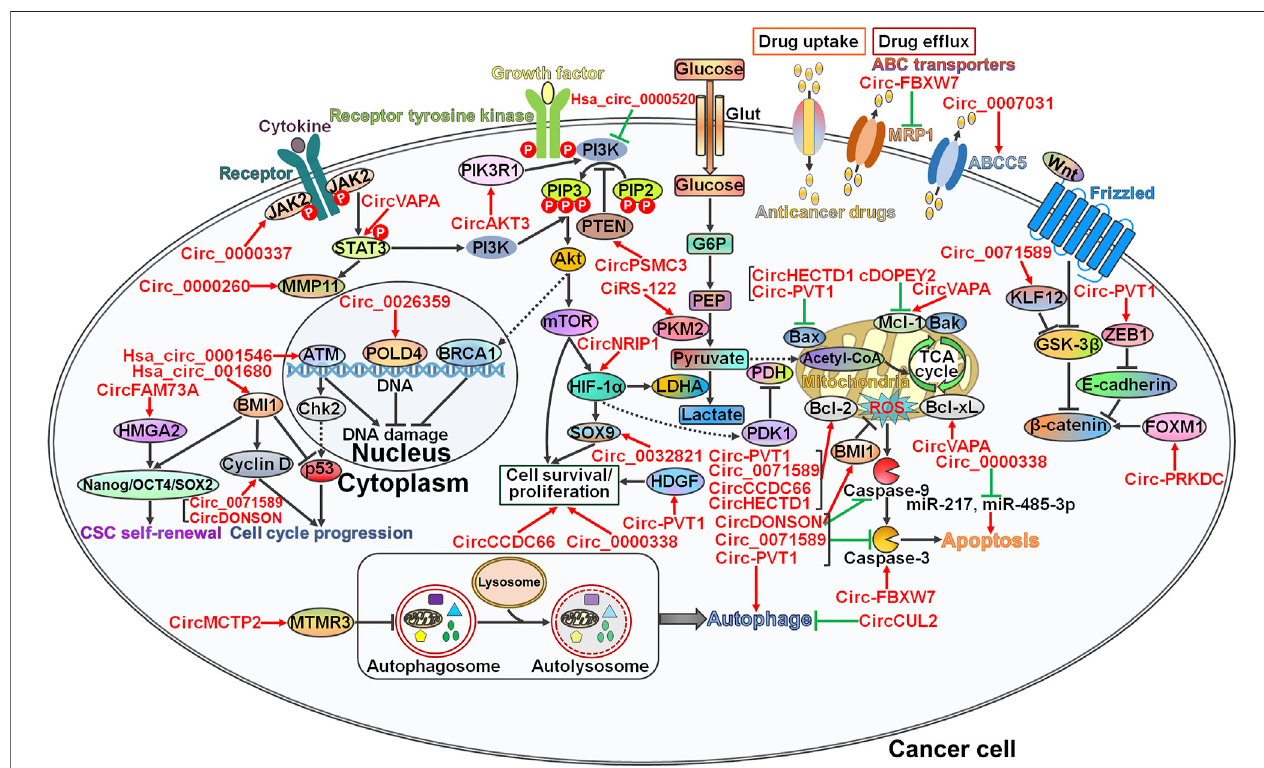
FIGURE2| TheunderlyingmechanismsinvolvedincircRNA-mediatedchemoresistanceingastrointestinalcancer.CircRNAsfunctionasmasterregulatorsofdrug resistanceingastrointestinal(GI)cancerviadiversepathways.Circ_0000337andcircVAPAstrengthenchemotherapy-resistantcharacteristicsofGIcancerbyactivating the JAK2/STAT3 signaling pathway. Circ_0000260induces an increase inthe expression level of MMP11, the downstream molecule ofthe JAK2/STAT3 pathway. Asa result, circ_0000260 promotes cancer cell metastasis and confers chemoresistance to GI cancer cells. Circ_0026359 and hsa_circ_0001546 exert opposite effects on the DNA damage repair pathway, and they serve as important players in GI cancer chemoresistance. Circ_0071589 and circDONSON accelerate cell cycle progressionbyelevatingCyclinDexpression.Consequently,thesecircRNAsinducethedrug-resistantphenotypeinGIcancer.CircFAM73AcausesCSCself-renewalin GI cancer via upregulating stemness-relevant transcription factors (e.g., Nanog, OCT4 and SOX2) by reinforcing HMGA2 expression. Hsa_circ_001680 promotes CSC growth by inducingthe keyregulator of CSC self-renewal, BMI1, leading tothe acquisition of chemoresistance in GIcancer. CircAKT3 and hsa_circ_0000520 affect the responsiveness of GI cancer cells to chemotherapy by regulating the PI3K/Akt signaling pathway. CircPSMC3 reduces the proliferation of GI cancer cells by increasing PTEN expression and sensitizes cancer cells to chemotherapeutic agents. Circ_0032821, circ-PVT1, circCCDC66 and circ_0000338 facilitate the survival and proliferation of GI cancer cells by controlling the expression of their cellular targets (e.g., SOX9 and HDGF). CiRS-122 and circNRIP1 favor glucose metabolism to fuel cancer cell growth, resulting in the development of drug resistance in GI cancer. Circ-FBXW7 decreases drug ef fl ux transporter MRP1 expression to augment the cytotoxicity of anticancer drugs toward GI cancer cells. In contrast, circ_0007031 raises the expression level of ABCC5 and thus protects GI cancer cells from chemotherapeuticagent-induced cellkilling.VariouscircRNAshavebeeninvolvedincelldeathpathways(apoptosisand autophagy).Particularly,circHECTD1andcirc- PVT1 diminish the expression of pro-apoptotic Bax. cDOPEY2, circVAPA, circ-PVT1, circ_0071589, circCCDC66 and circHECTD1 can target anti-apoptotic proteins such as Mcl-1, Bcl-2 and Bcl-xL. CircDONSON, circ_0071589 and circ-PVT1 limit the expression of the apoptotic effector caspase-3, while circ-FBXW7 has an antagonistic role.Circ_0000338suppresses cellapoptosis byspongingmiR-217 and miR-485-3p. BothcircMCTP2and circCUL2 blockthe autophagic fl ux. Giventhe association between autophagy and drug resistance, these two circRNAs play a critical role in regulation of chemotherapy response in GI cancer. Circ-PVT1 and circ- PRKDC mobilize the Wnt/ β -catenin signaling cascade to drive the EMT process and cancer cell invasion. The EMT-inducing potential of circRNAs accounts for their promotive effects on the development of drug resistance in GI cancer. Arrows in red represent activation effect, and the ‘ T ’ symbols in green represent inhibition effect. JAK2,Januskinase 2;STAT3, signal transducer and activator oftranscription3; MMP11, matrixmetalloproteinase 11; HMGA2, high mobility group A2;Oct4, octamer- binding transcription factor 4; SOX2, SRY-box transcription factor 2; CSC, cancer stem cell; BMI1, B lymphoma Mo-MLV insertion region 1; MTMR3, myotubularin- related protein 3; ATM, Ataxia telangiectasia mutated; Chk2, checkpoint kinase 2; POLD4, DNA polymerase δ subunit 4; BRCA1, breast cancer type 1 susceptibility protein; PIK3R1, phosphatidylinositol 3-kinase regulatory subunit 1; PI3K, phosphatidylinositol 3-kinase; PIP3, phosphatidylinositol 3,4,5-trisphosphate; PIP2, phosphatidylinositol 4,5-bisphosphate; PTEN, phosphatase and tensin homolog; Akt, protein kinase B; mTOR, mammalian target of rapamycin; HIF-1 α , hypoxia- induciblefactor-1 α ;SOX9,SRY-boxtranscriptionfactor9;Glut,glucosetransporter;G6P,glucose-6-phosphate;PEP,phosphoenolpyruvate;PKM2,theM2isoformof pyruvate kinase; LDHA, lactate dehydrogenase A; HDGF, hepatoma-derived growth factor; PDH, pyruvate dehydrogenase; PDK1, pyruvate dehydrogenase kinase 1; MRP1,multidrugresistanceprotein1;ABCC5,ATP-bindingcassettesubfamilyCmember5;Bcl-2,B-celllymphoma-2;Bax,Bcl-2-associatedXprotein;Mcl-1,myeloid cellleukemia-1;Bak,Bcl-2antagonistickiller;TCA,tricarboxylicacid;ROS,reactiveoxygenspecies;Bcl-xL,B-celllymphoma-extralarge;KLF12,kruppel-likefactor12; GSK-3 β , glycogen synthase kinase-3 β ; ZEB1, Zinc fi nger E-box-binding homeobox 1; FOXM1, forkhead fox protein